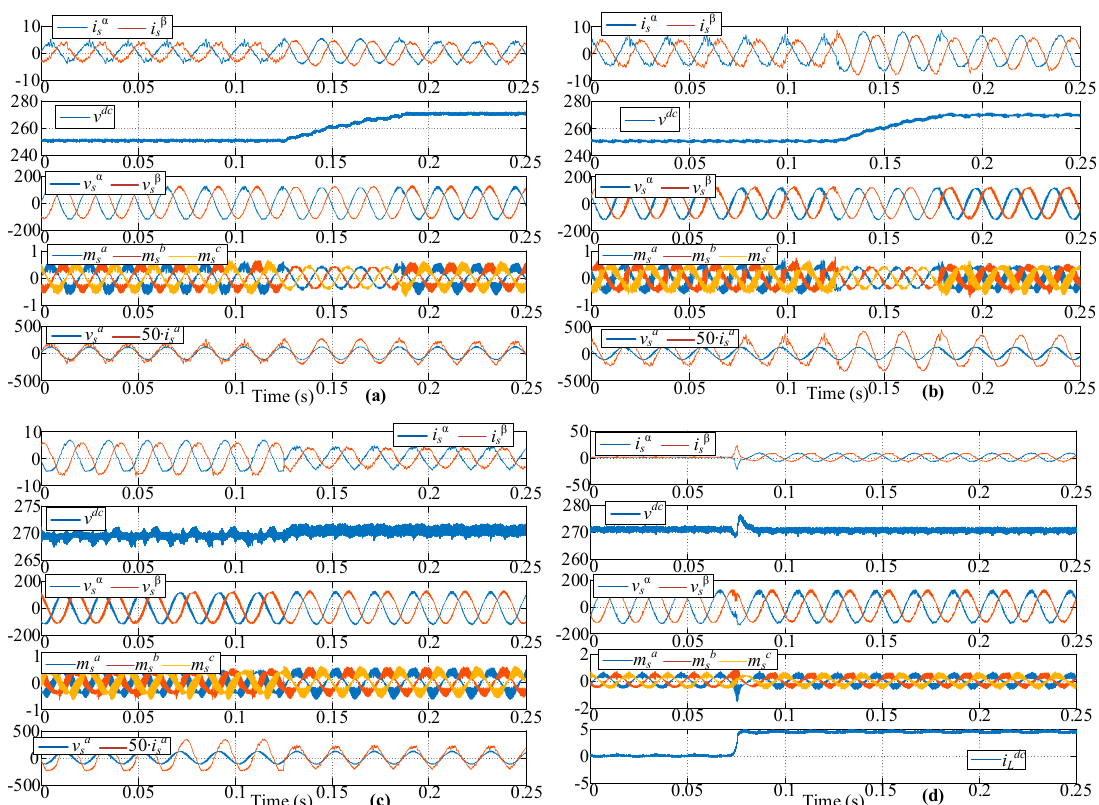
Figure 7. Experimental Results, ( a ) dc voltage step up with unitary power factor, ( b ) dc voltage step up with power factor of 0.7( inductive ), ( c ) change on the power factor, ( d ) load step up from 0 (A) to 4.7 (A). Figure 7a,b show a dc voltage step response. Firstly, a dc voltage step is applied with a unity power factor (Figure 7a); then, it is also imposed with a 0.7 ( inductive ) power factor (Figure 7b). The results of these tests are obtained considering the maximum power rating of the converter as 2 kW. The results show a very fast dynamic with no overshoot, as expected from the designed controller and simulation results; the total transient time for the voltage step from 250 up to 270 V is about 70 ms.